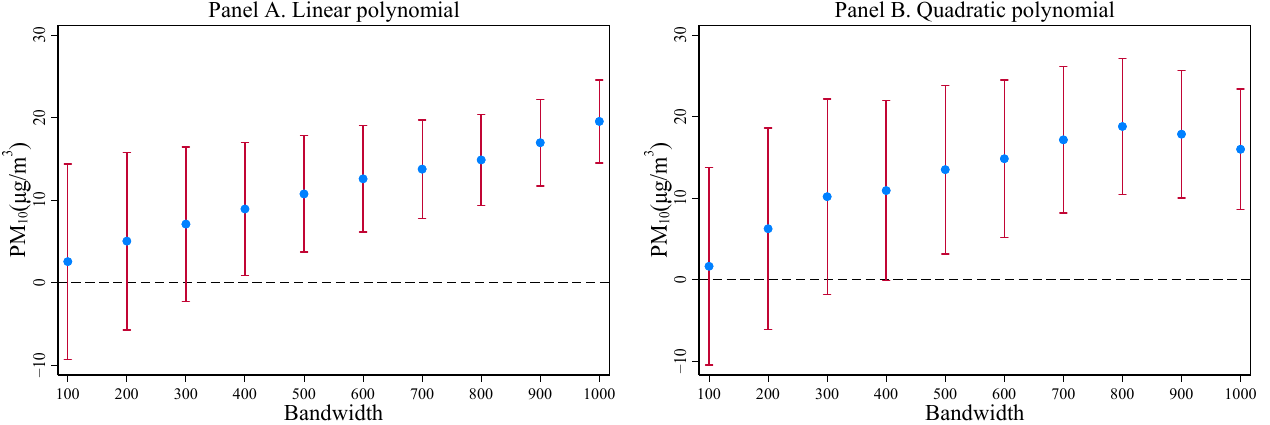
Figure A4. Robustness to alternative bandwidths for the impact of the Huai River Policy on PM 10 . Notes: Each point plots the point estimate of a separate estimation of α 1 in Equation (2) along with the 95 percent confidence interval, ranging from 100 km to 1000 km bandwidths. ( Panel A ) plots estimates using linear polynomials in distance. ( Panel B ) plots estimates from equivalent regressions but using second-order polynomials in distance. Each RD estimate is based on the MSE bandwidth selection method and triangular kernel function.